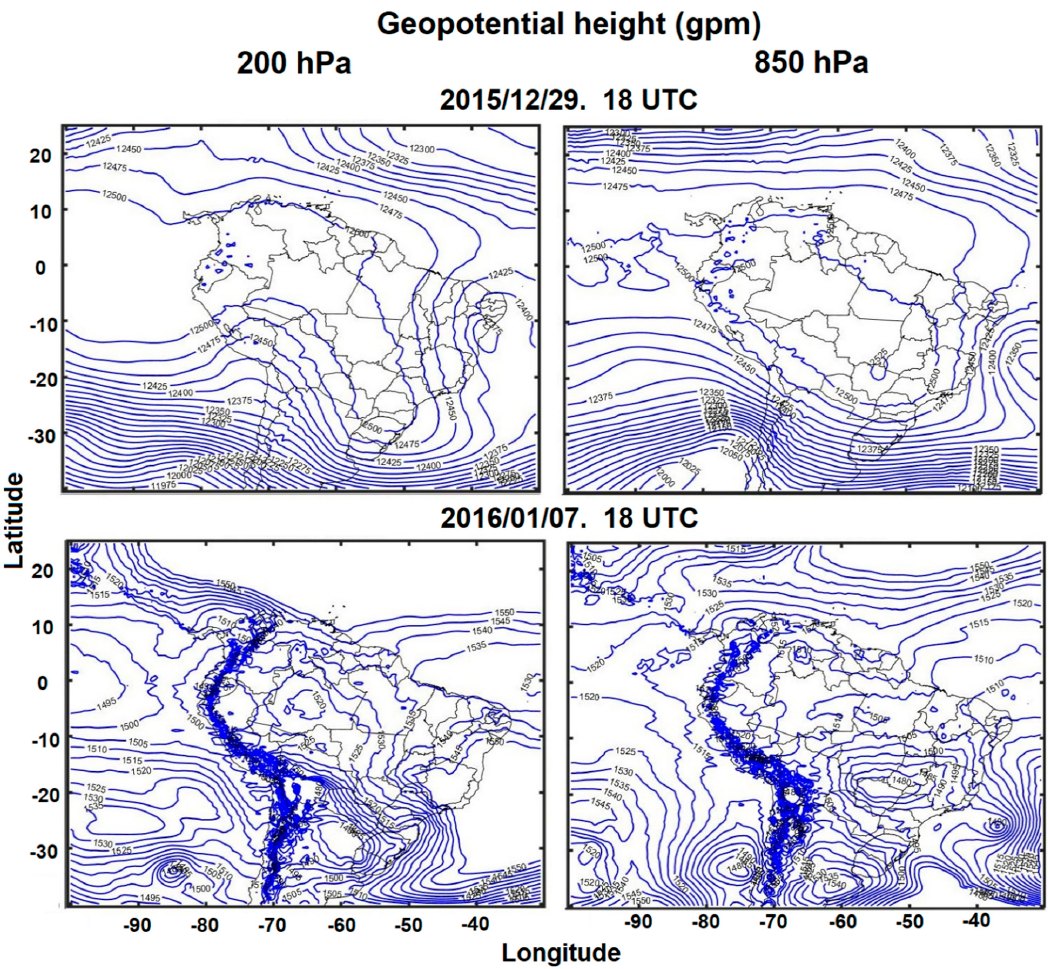
Figure 4. Geopotential fields at 850 and 200 hPa, for December 29 2015 (upper panels) and January 7 2016 (lower panels).